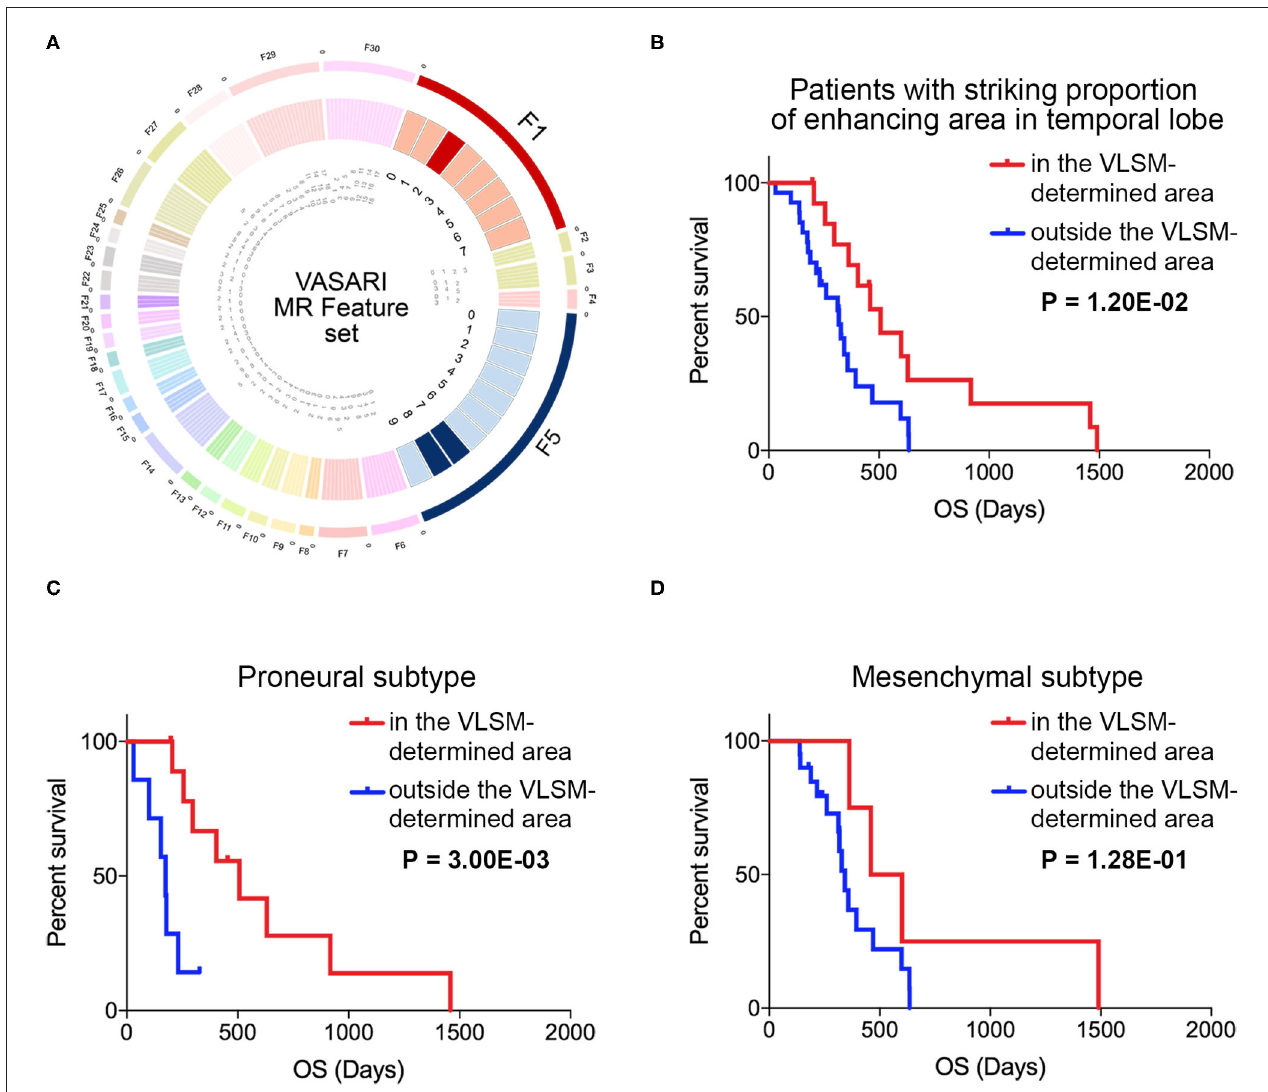
FIGURE 5 | The VASARI feature set used for screening samples and survival analysis in and outside the VLSM-determined area. (A) The F1 and F5 in VASARI feature sets were applied. Patients with GBM involved temporal lobe with over 95% proportion of enhancing area were carried out for survival analysis. (B) Survival analysis illustrated the significantly different prognosis of patients with GBM in and outside the VLSM-determined area ( P = 1.20E-02). (C) Survival analysis illustrated the significantly different prognosis of patients with proneural subtype of GBM in and outside the VLSM-determined area ( P = 3.00E-03). (D) Survival analysis illustrated the prognosis of patients with mesenchymal subtype of GBM in and outside the VLSM-determined area ( P = 1.28E-01). P -value was determined by log-rank